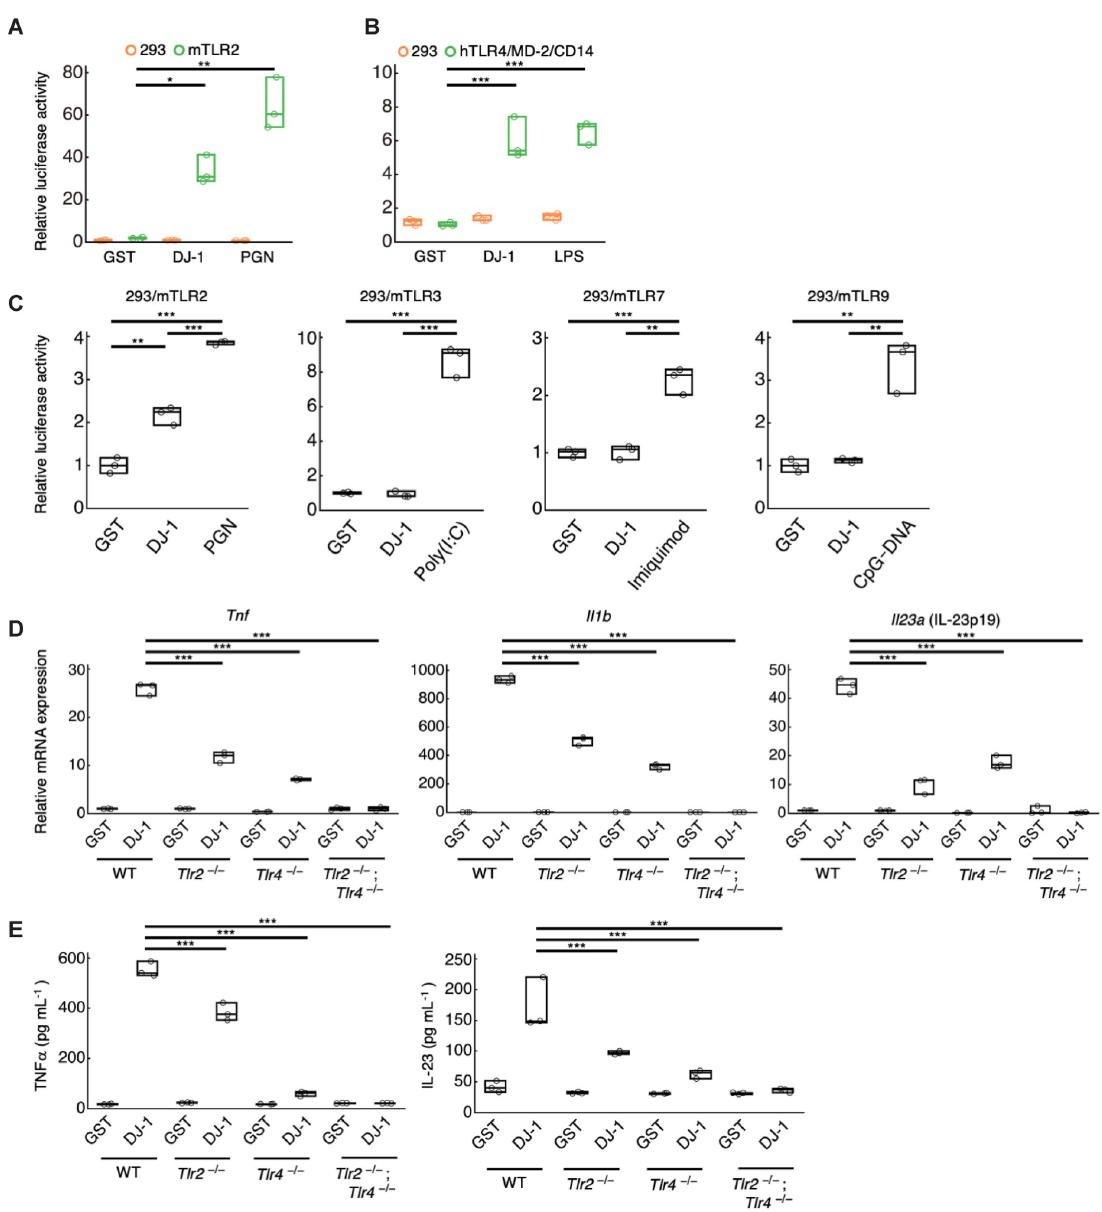
Fig 2. DJ-1 activates TLR2 and TLR4 to trigger inflammation. (A) The relative luciferase activity of NF- κ B reporter in HEK293 cells or murine stably TLR2-expressing HEK293 cells treated with 1 μ M of recombinant DJ-1 protein or PGN (TLR2 ligand). (B) The relative luciferase activity of NF- κ B reporter in HEK293 cells or human stably TLR4/MD-2/CD14-expressing HEK293 cells treated with 1 μ M of recombinant DJ-1 protein or LPS (TLR4 ligand). The relative values compared to those in HEK293 cells treated with 1 μ M of control GST protein are shown (A, B) . (C) Relative luciferase activity of the NF- κ B reporter in each murine transiently TLRs-expressing HEK293 cells treated with 1 μ M of recombinant GST (as a control) or DJ-1 protein or TLR ligands (Poly(I:C): a TLR3 ligand, Imiquimod: a TLR7 ligand, and CpG-DNA: a TLR9 ligand). (D) The mRNA expression levels of inflammatory cytokines in WT, TLR2-deficient, TLR4-deficient, TLR2- and TLR4-double-deficient BMMs 1 h after stimulation with 0.3 μ M of recombinant DJ-1 protein or control GST protein. The relative values compared to the mRNA expression levels in GST-treated BMMs are shown. (E) The protein expression levels of inflammatory cytokines in the WT, TLR2-deficient, TLR4-deficient, TLR2- and TLR4-double-deficient BMMs (for TNF α ), and BMDCs (for IL-23) 3 h after treatment with 1 μ M of recombinant DJ-1 or control GST protein � p < 0.05, �� p < 0.01, ��� p < 0.001 (one- way ANOVA with Dunnett correction [ A–E ]). All experiments were performed in triplicate. The results are representative of 2 (A, E) or 3 (B–D) independent experiments. The data underlying this figure can be found in S1 Data. ANOVA, analysis of variance; BMDC, bone marrow–derived dendritic cell; BMM, bone marrow–derived macrophage; GST, glutathione-S-transferase; LPS, lipopolysaccharide; NF- κ B, nuclear factor kappa B; PGN, peptidoglycan; TLR, Toll-like receptor; WT, wild-type.